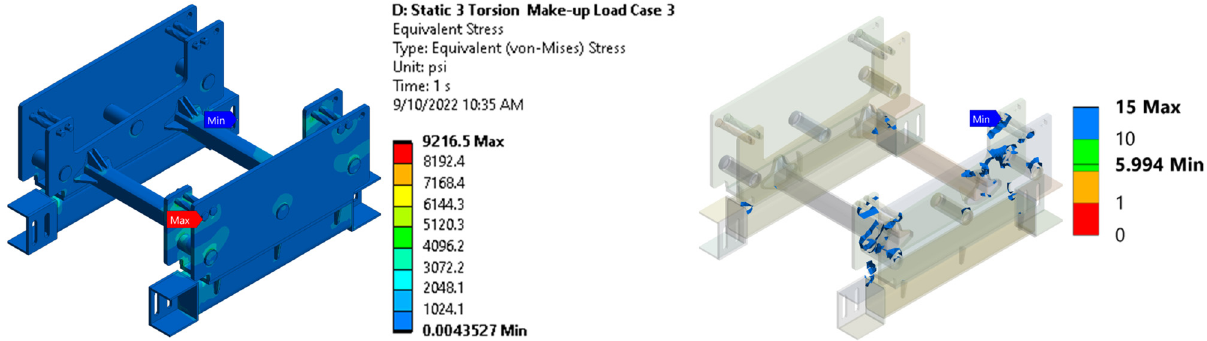
Figure 10: Equivalent ( Von - Mises ) stress and safety factor plot for load case 3 – Torque make - up and break -